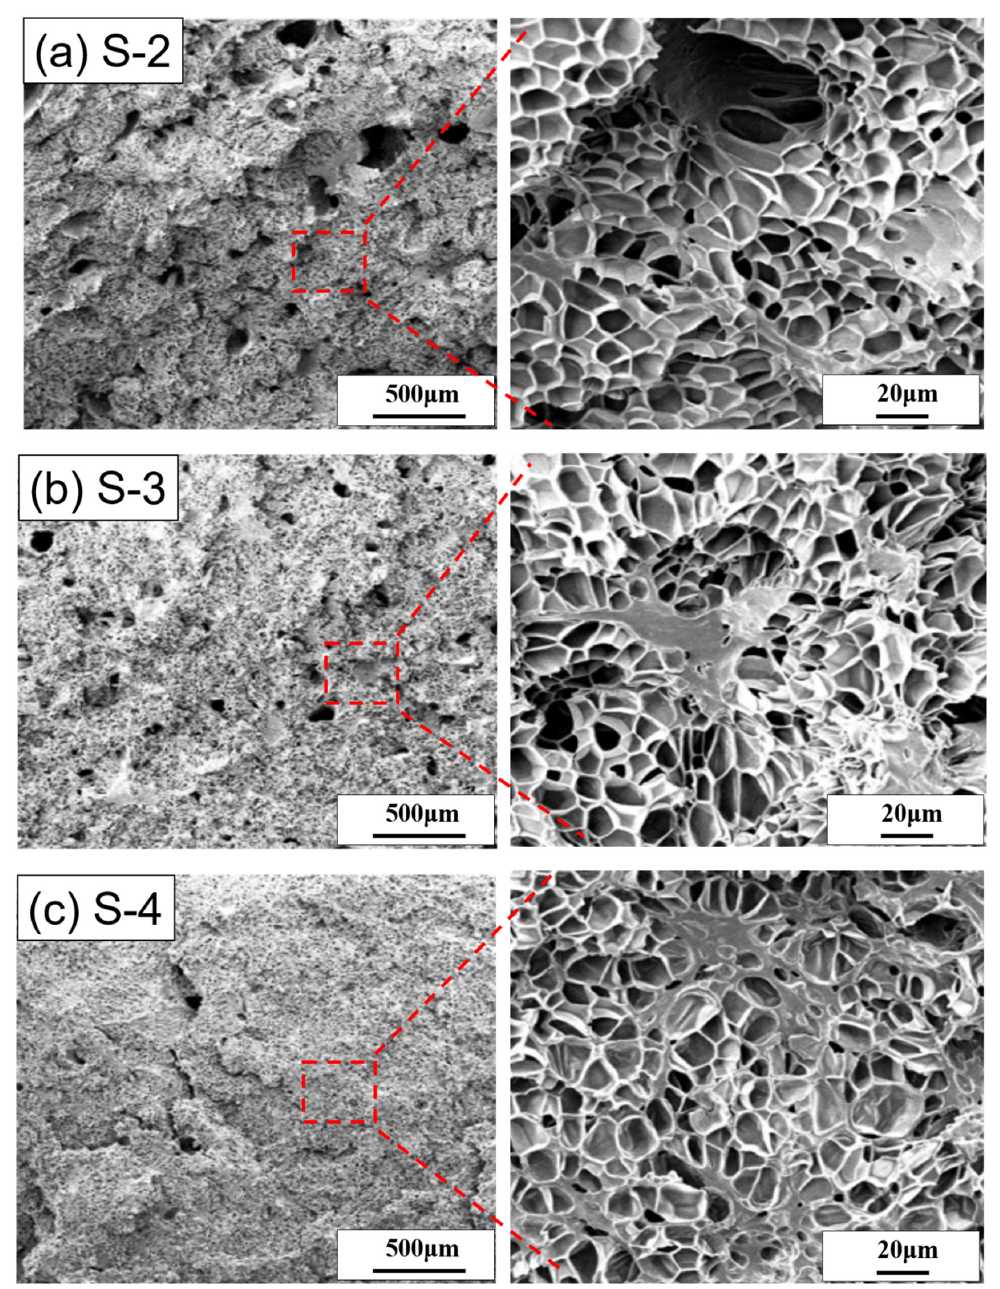
Figure 7. The SEM images of cell structure at the foaming temperature of 95 °C and the foaming pressure of 17 MPa. ( a ) [S-2], ( b ) [S-3], and ( c ) [S-4].